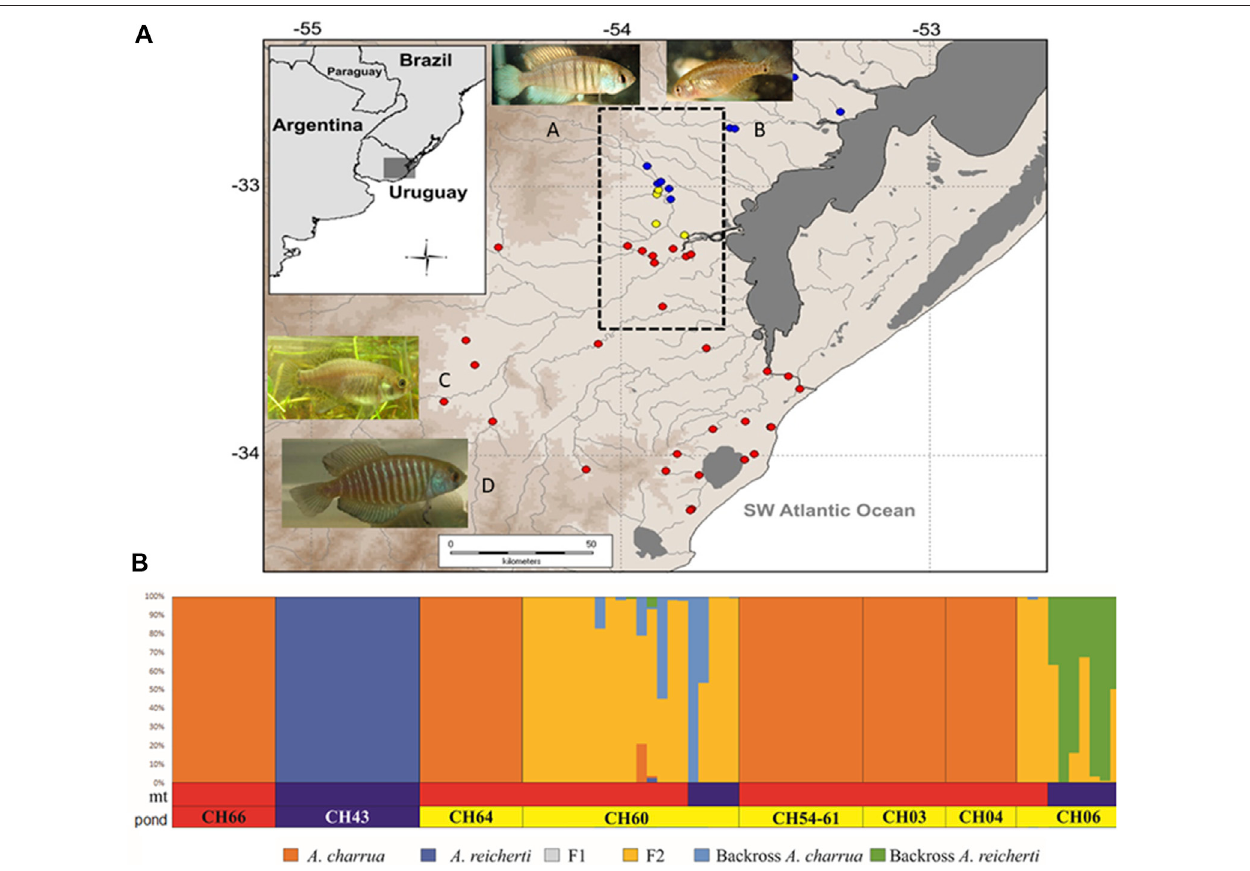
FIGURE 2 | Geographic distribution and genotype assignment of individuals sampled in the hybrid zone of the Patos-Merin coastal lagoons basin system, South America. (A) The contact area between both taxa is delimited for the dotted line rectangle. Ponds are represented by circles: A. charrua (red circles), A. reicherti (blue circles)andhybridpopulations(yellowcircles)Inthetop,male (A) andfemale (B) oftheparentalspecies A.reicherti ;inthebottom,female (C) andmale (D) oftheparental species A. charrua . (B) Posterior probabilities of the ancestral genotype class estimated with NewHybrids, under Uniform prior assumption. Each individual is representedasaverticalbardividedintosixsegments.Eachcolorindicatestheposteriorprobabilityofanindividualassignmenttopure A.reicherti (blue),pure A.charrua (red), F1(grey),F2(yelow),and fi rstgenerationbackcrossofaF1hybridwithapure A.reicherti (BC1R,green)orwithapure A.charrua (BC1C,sky).Eachofthesampled pondsinthehybridzonearelabeledbelowthebarplots,andnamedasfollows:CH66,CH43,CH64,CH60,CH54-61,CH03,CH04,andCH06.mt(mitochondrial)bars: represent the Cytb haplotype assignation of each individual to A. charrua (red) or A. reicherti (blue) species. Modi fi ed from García et al.